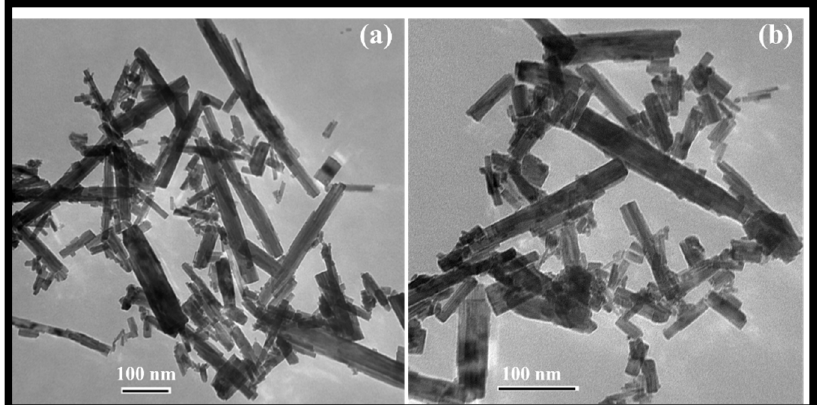
Figure 1. Typical ( a , b ) TEM images of WO 3 nanorods.